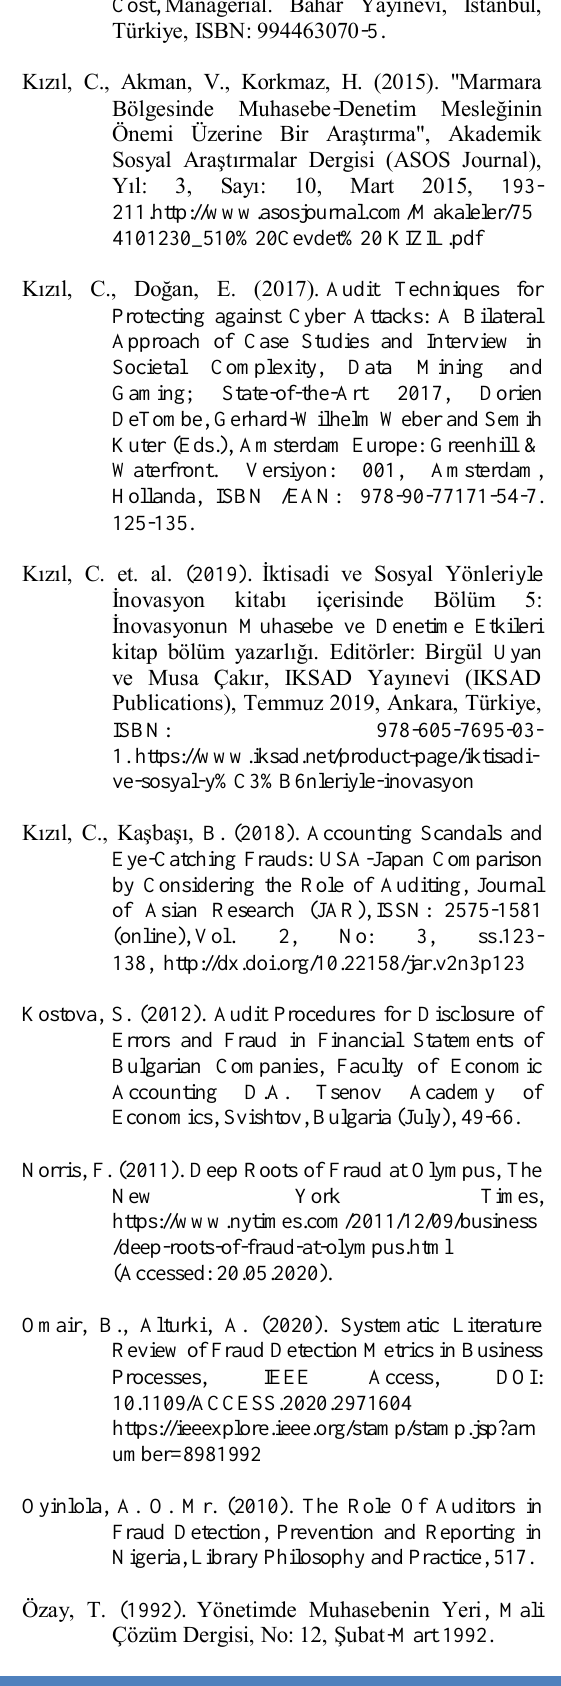
Auditing Techniques to Avoid Cost Accountings